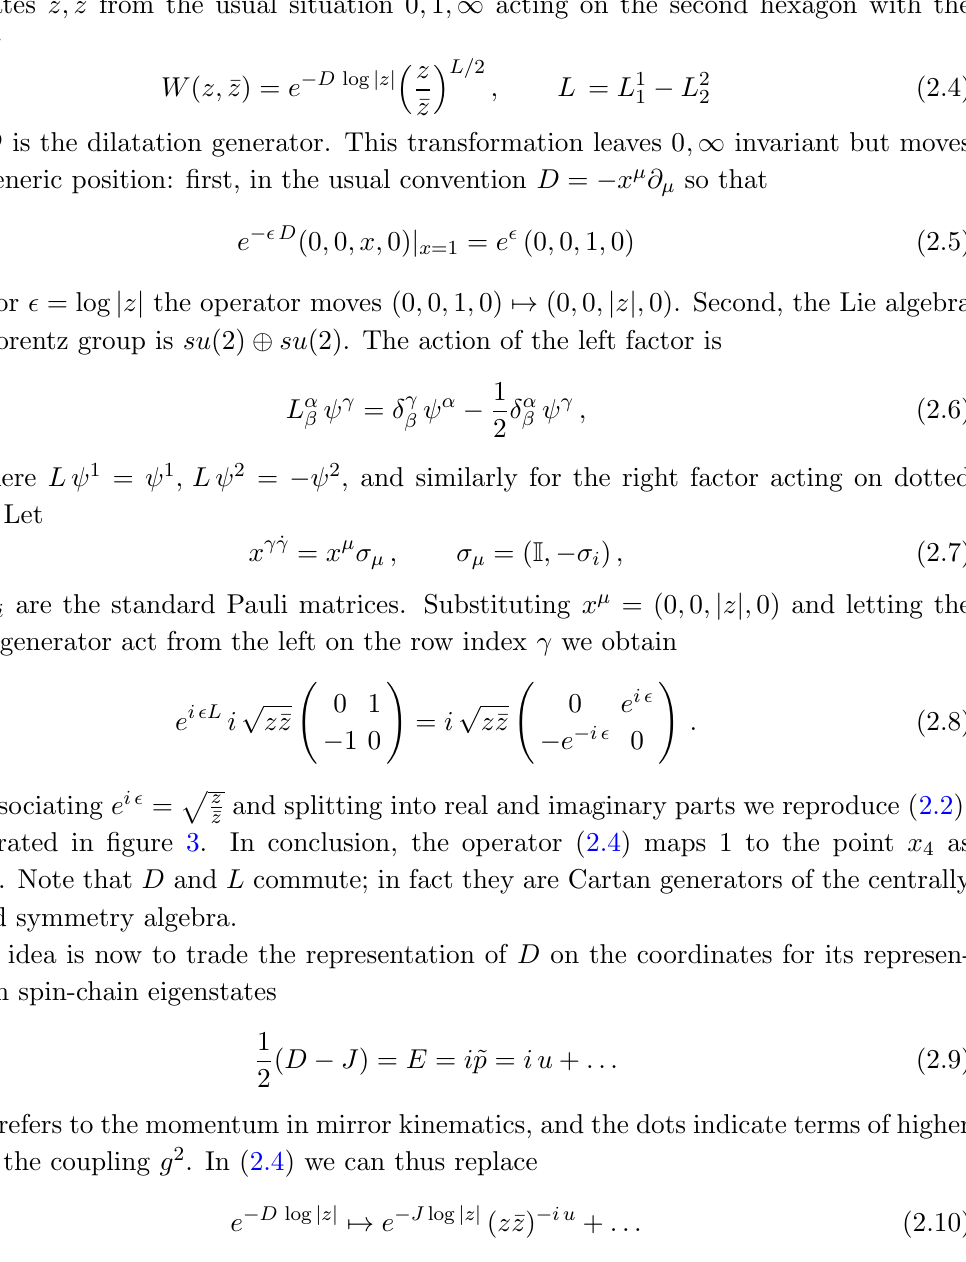
log( z= (cid:22) z ) (red 2